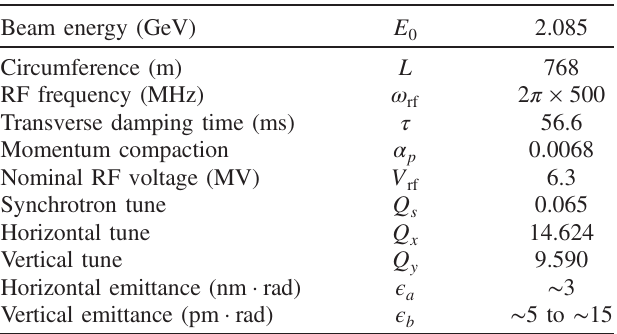
TABLE I. CesrTA machine parameters for crabbing studies.